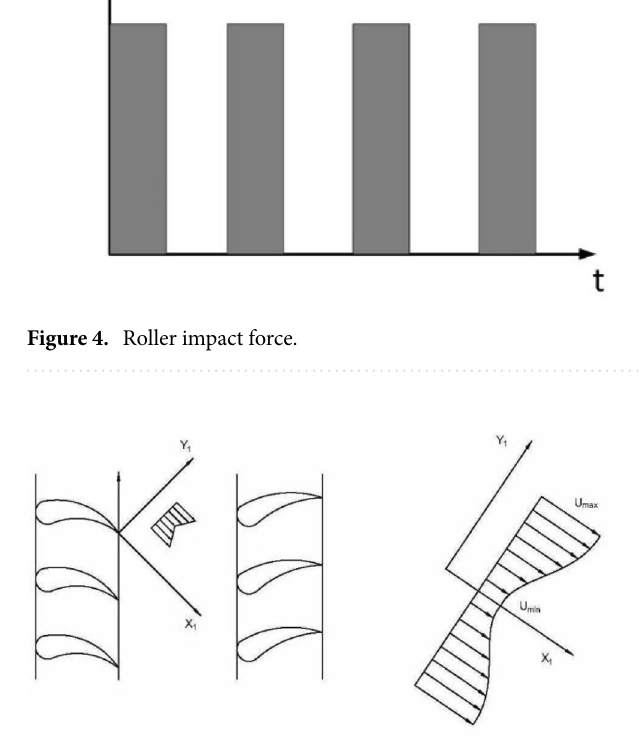
Figure 5. Schematic diagram of aerodynamic excitation force of inlet guide